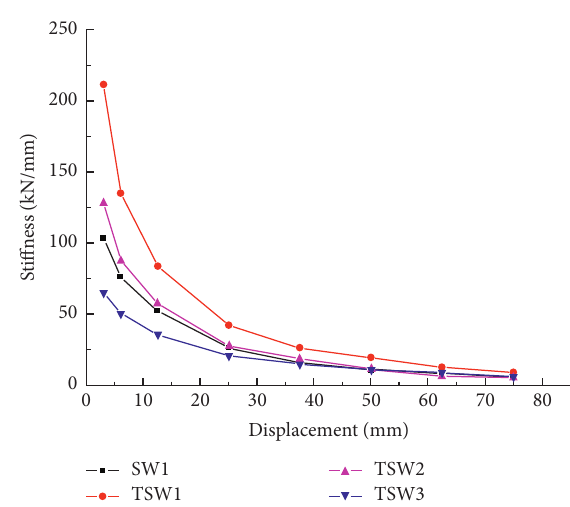
Figure 17: Stiffness degradation of four specimens. Table 4: Summary of ductility parameters for four specimens. Specimen